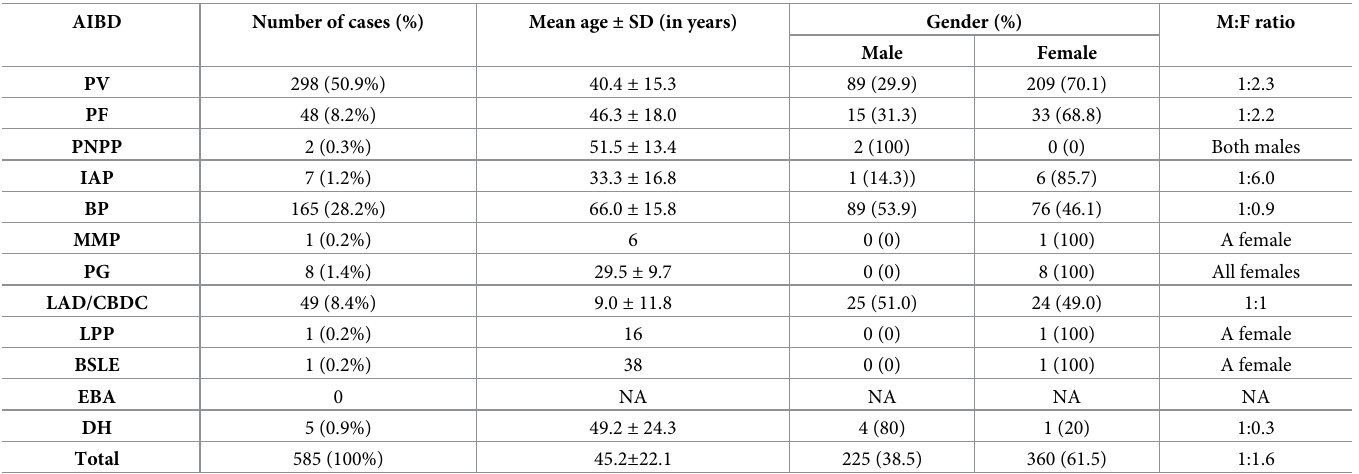
Fig 3. Bar chart for the additional diseases in patients with autoimmune bullous diseases. The total number of patients who had an additional chronic disease was 93. https://doi.org/10.1371/journal.pone.0254634.g003 case, patients waited from two days to 34.3 weeks after lesions appeared before they went to the hospital; the median was 4.2 weeks. About 16% (93/585) of the patients had one chronic disease or more in addition to the AIBD; most of them (86%) presented with hypertension, diabetes or both (Fig 3). The intraepidermal group of AIBDs included 3355 patients (60.7%), while the subepidermal group included 230 cases (39.3%). All but one of the AIBDs were observed in this study; none of the patients had EBA (Table 1). PV was the most common disease (50.9%), followed by BP Table 1. Characteristics of the included 585 patients with different types of